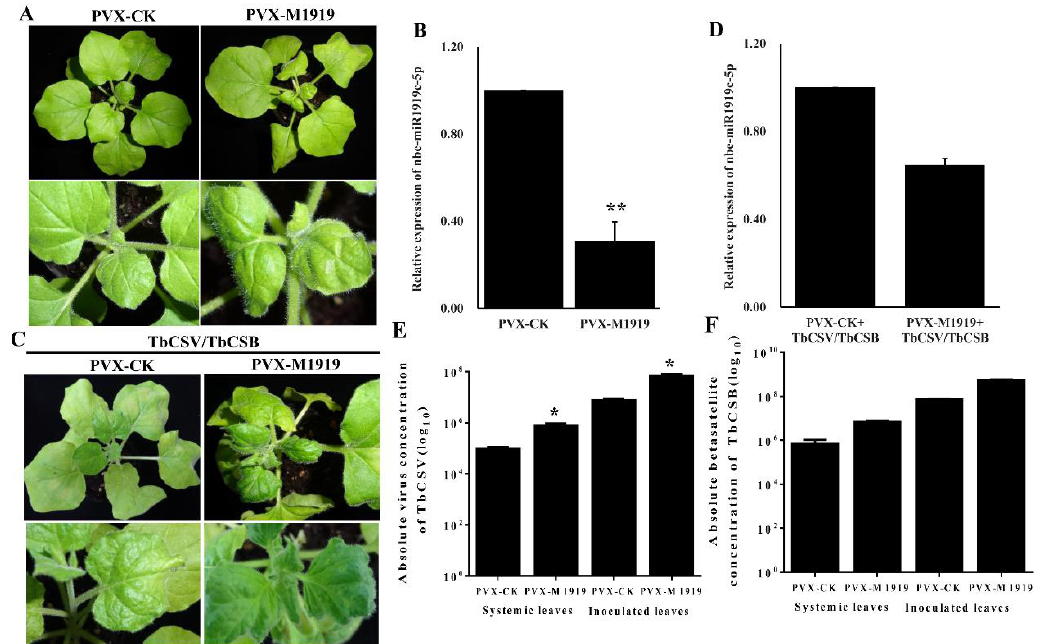
Figure 2. Suppression of nbe-miR1919c-5p expression enhances the leaf curling symptom induced by TbCSV/TbCSB infection and viral DNA accumulation. ( A ) A potato virus x (PVX)-based miRNA vector (PVX-M1919) was used to suppress the expression of nbe-miR1919c-5p. At 7 dpi, the PVX-M1919-inoculated plant showed strong leaf curling symptoms but not the control plant (PVX-CK). ( B ) qRT-PCR results showed that the expression of nbe-miR1919c-5p in the PVX-M1919-inoculated plants was significantly reduced compared with the control plants. ( C ) The PVX+TbCSV/TbCSB-inoculated and the PVX-M1919+TbCSV/TbCSB-inoculated plants were photographed 7 days after the second inoculation. Only the PVX-M1919+TbCSV/TbCSB-inoculated plants showed severe leaf curling symptoms. ( D ) qRT-PCR results showed that the expression of nbe-miR1919c-5p in the PVX-M1919+TbCSV/TbCSB-inoculated plants was significantly reduced. ( E ) Detections of TbCSV DNA copy numbers in the inoculated and the systemic leaves harvested from the PVX+TbCSV/TbCSB-inoculated plants or the PVX-M1919+TbCSV/TbCSB-inoculated plants. ( F ) Detection of TbCSB DNA copy numbers in the inoculated and the systemic leaves harvested from the PVX+TbCSV/TbCSB-inoculated plants or the PVX-M1919+TbCSV/TbCSB-inoculated plants. *, P < 0.05; **, P < 0.01; determined by the Student’s t -test.